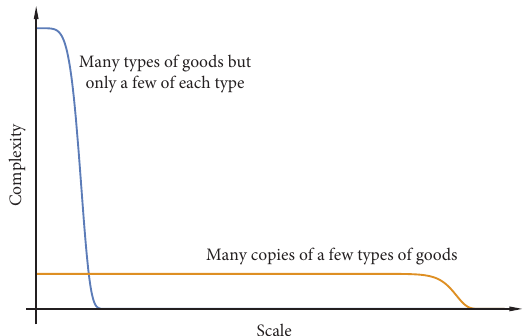
Figure 2: Representative complexity profiles for random, coherent, and correlated systems (see Figure 1). Any given system may have aspects of each at various